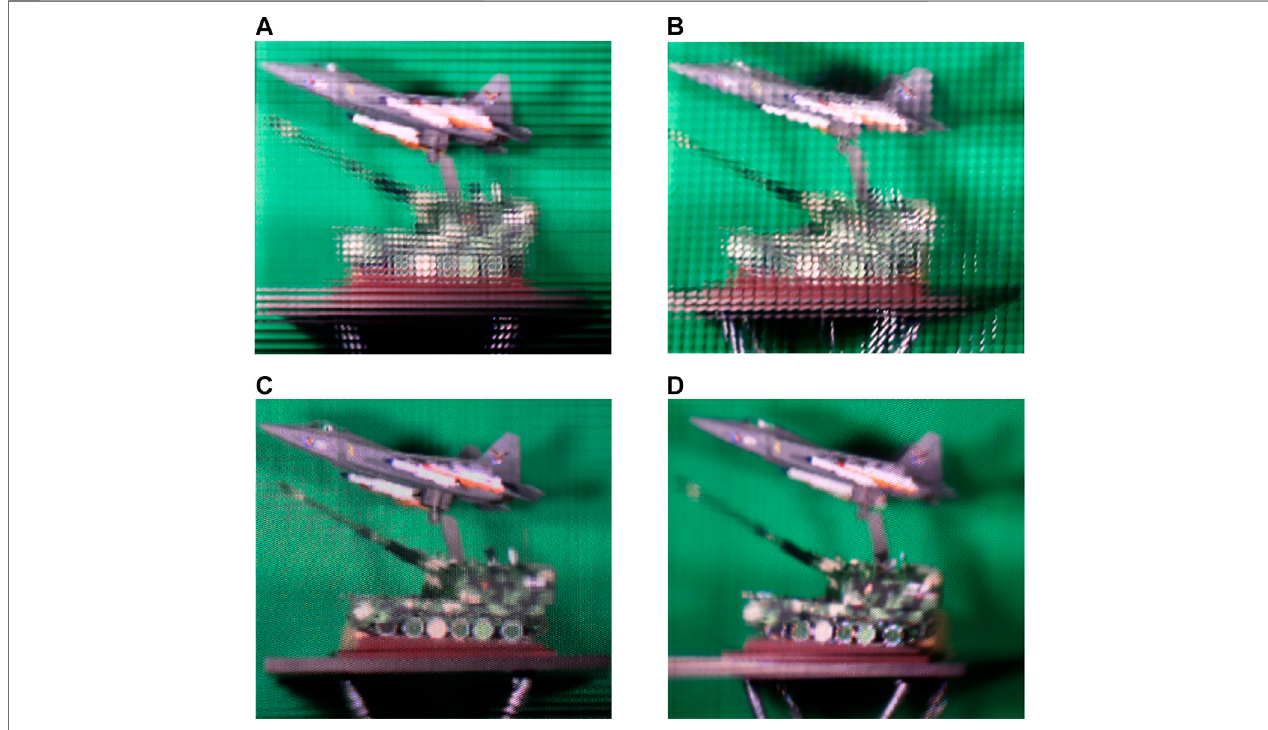
FIGURE14| Acomparisonofopticalreconstructionresultsfortherealcapturesystem.SPOC: (A) left7 ° viewingangleand (B) right7 ° viewingangle.Theproposed method: (C) left 7 ° viewing angle and (D) right 7 ° viewing angle.